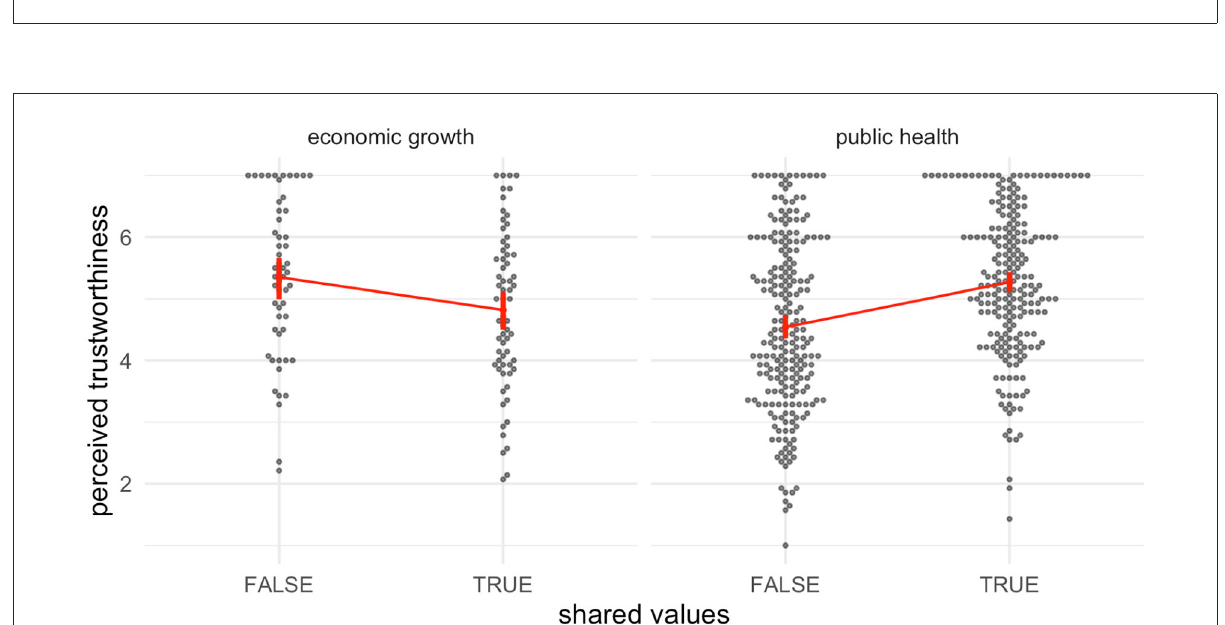
FIGURE5 Data, group means, and 95% confidence intervals for H5-shared, interaction of shared values and participant values. Panels correspond to participant values.